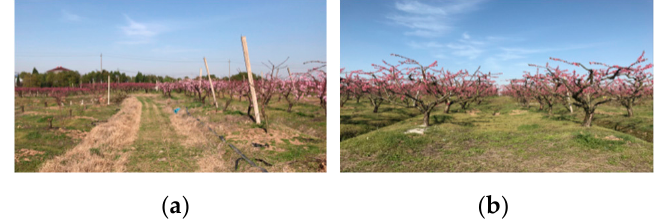
Figure 1. Orchard environment division: ( a ) The transportation environment; ( b ) The working environment.